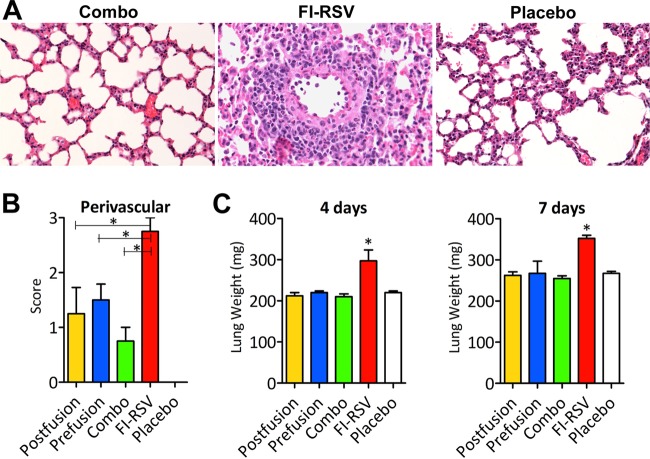
RSV VLP vaccines do not induce “vaccine-enhanced disease” in murine lung. (A) Hematoxylin and eosin staining of mouse lung 4 days after viral challenge. Microscopic examination of the lungs after the combo VLP vaccination shows the absence of or minor pulmonary pathology. On the other hand, the FI-RSV vaccination induces a very high perivascular immune infiltration. A placebo control is included as a reference. (B) Perivascular infiltration was scored by blind evaluation of sections of mouse lung stained with hematoxylin and eosin 4 days after the viral challenge. The scores range from 0 for normal to a maximum of 3 for massive infiltration. An asterisk indicates a statistically significant difference between VLP vaccination and FI-RSV (P < 0.05). (C) Mouse lungs were harvested 4 and 7 days after RSV challenge and weighed. An asterisk indicates a statistically significant difference with respect to the VLP vaccines and placebo control (P < 0.05).